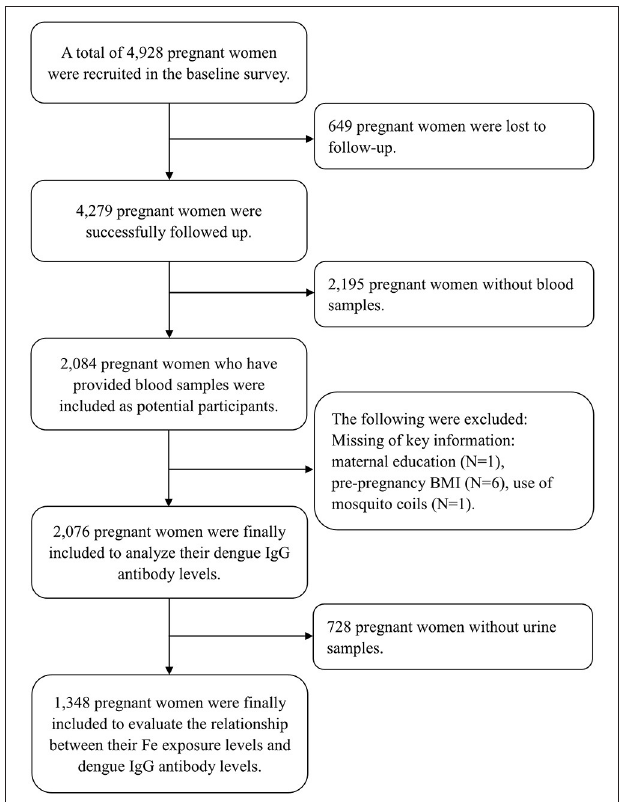
FIGURE 1 | Chart of the cohort study participants